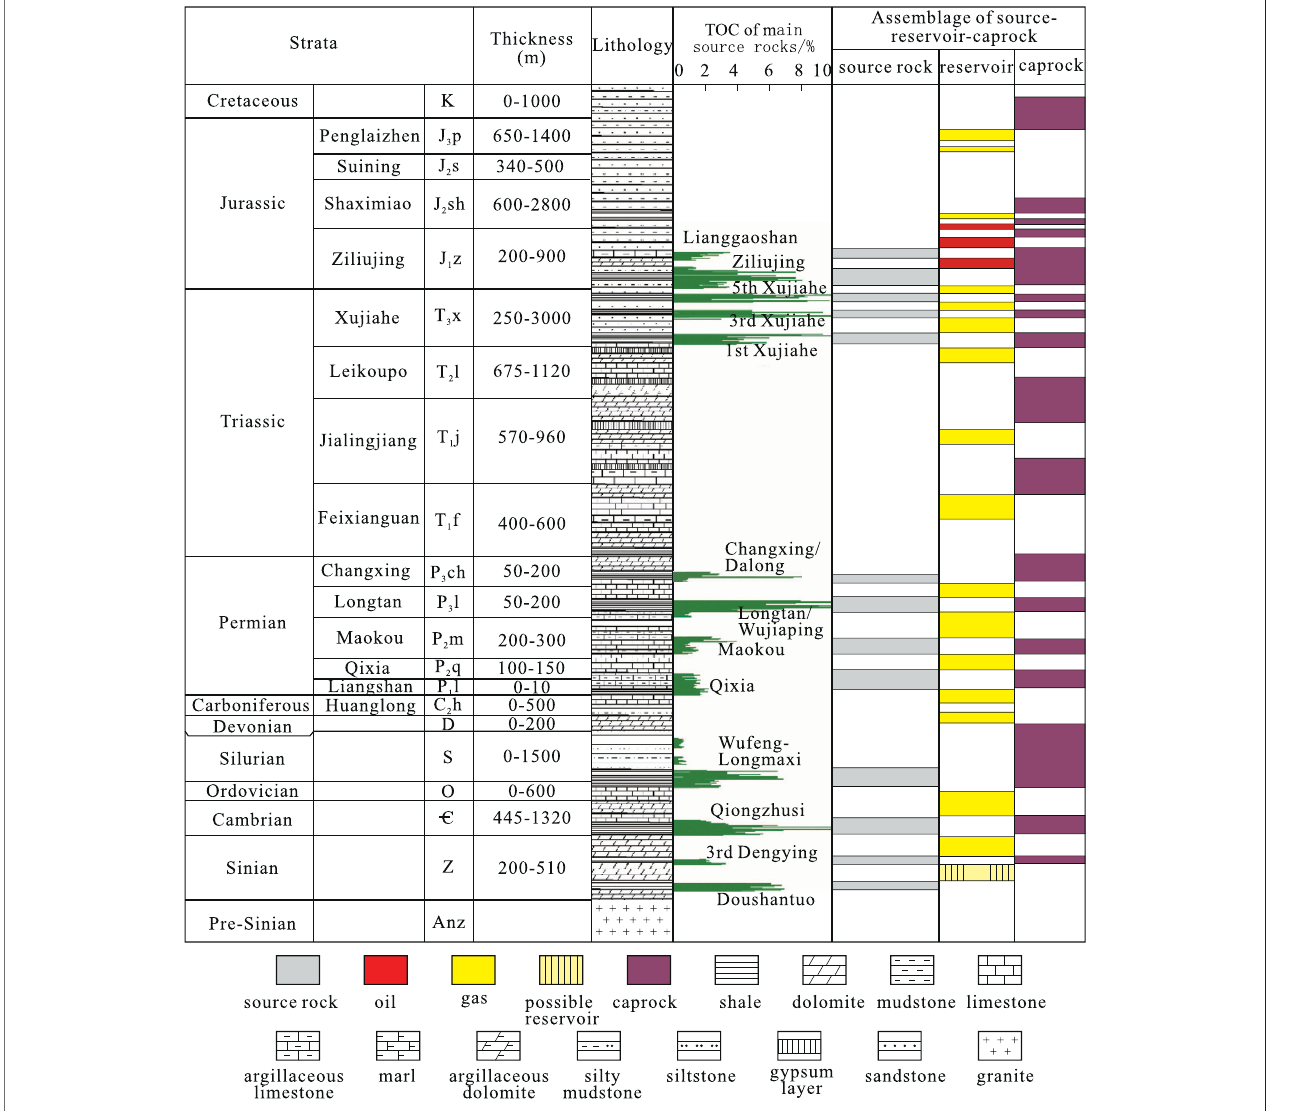
Frontiers in Earth Science |